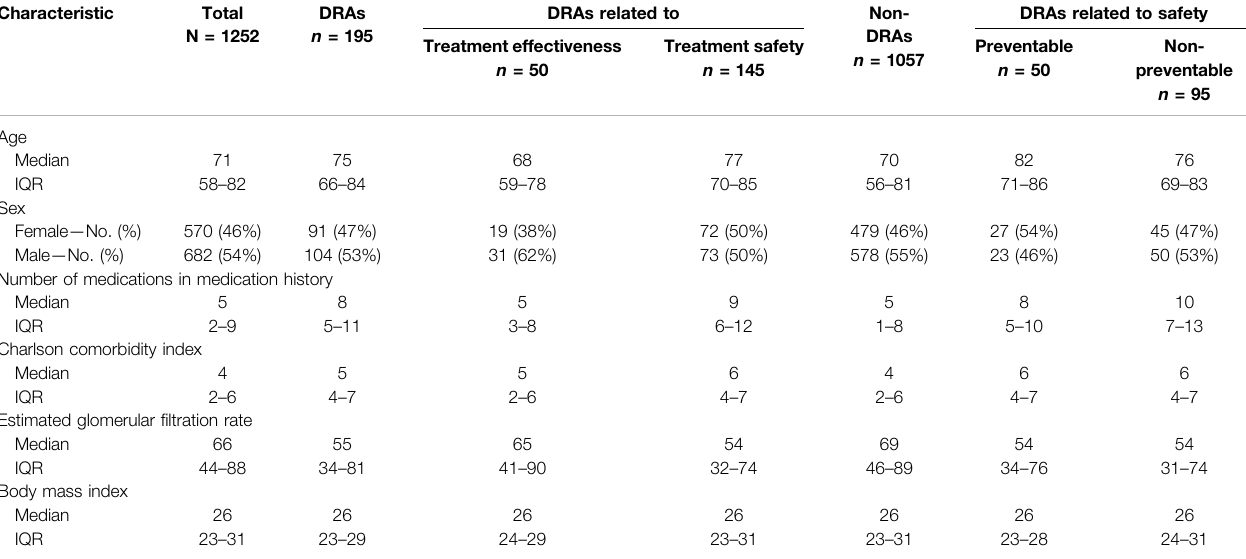
TABLE 1 | Demographic and clinical characteristics of the study sample and the comparison of subgroups.